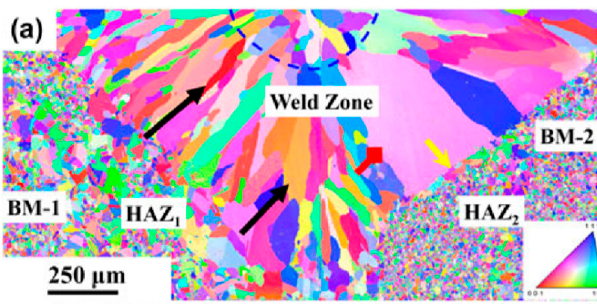
Figure 8. Microstructural characterization by means of EBSD (Electron Backscatter Diffraction) inverse pole figure analysis of the dissimilar welds. BM-1: Al 0.1 CoCrFeNi HEA; BM-2: AISI304 stainless steel (Reproduced from [65] with permission from Cambridge University Press, 2019).